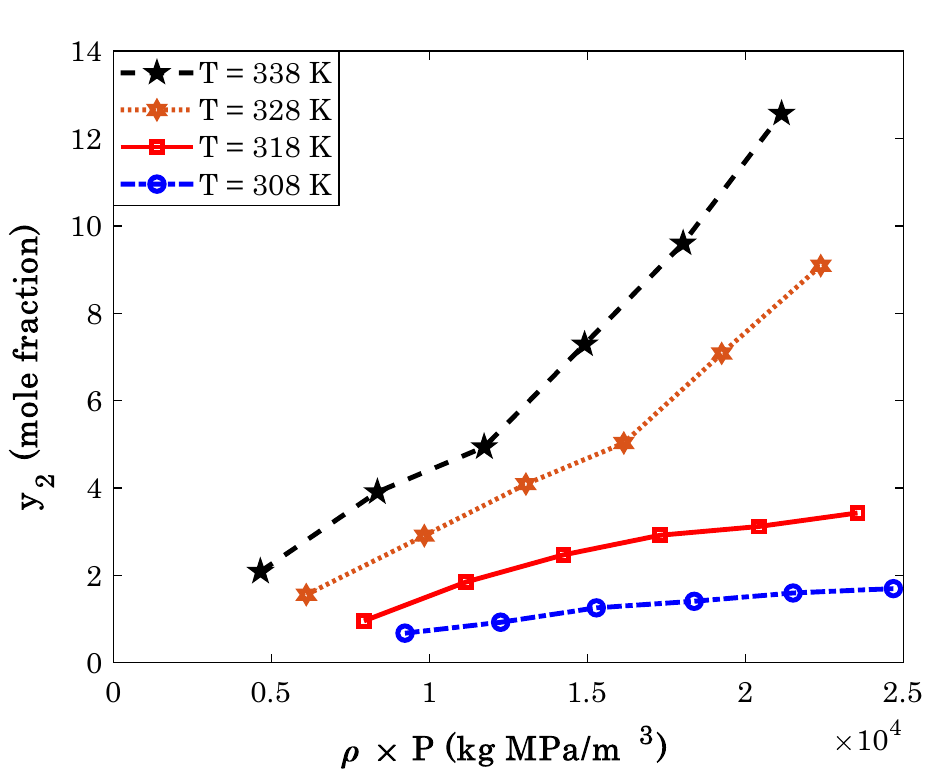
Figure 3. The variation of sorafenib tosylate solubility in the SCCO 2 by the solvent density (the cartesian